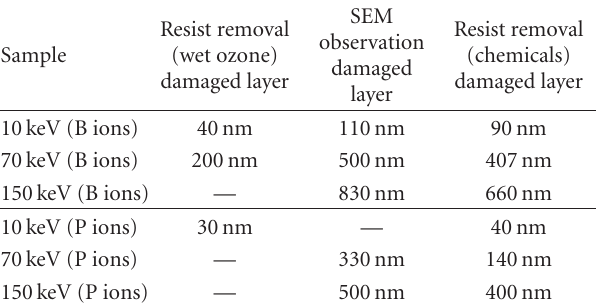
Table 3: The damaged layer thickness measured by resist removal using wet ozone, SEM images, and resist removal using chemicals.